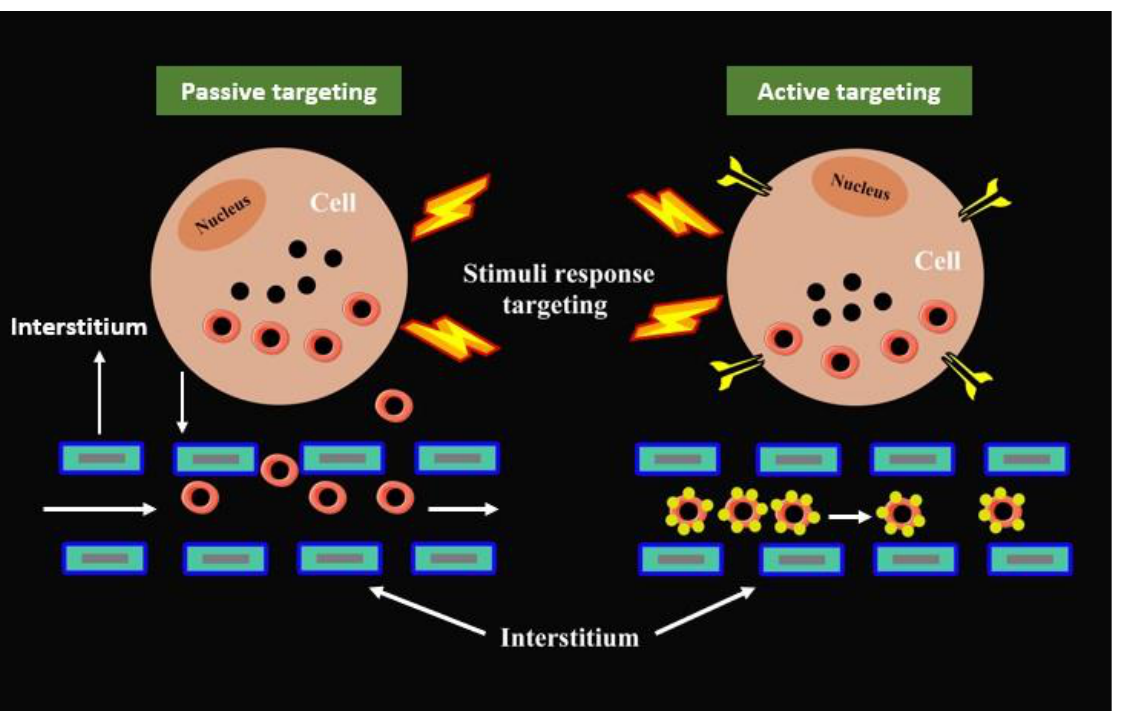
Figure 2. General mechanism of delivering drugs to the targeted cell by natural polymer.